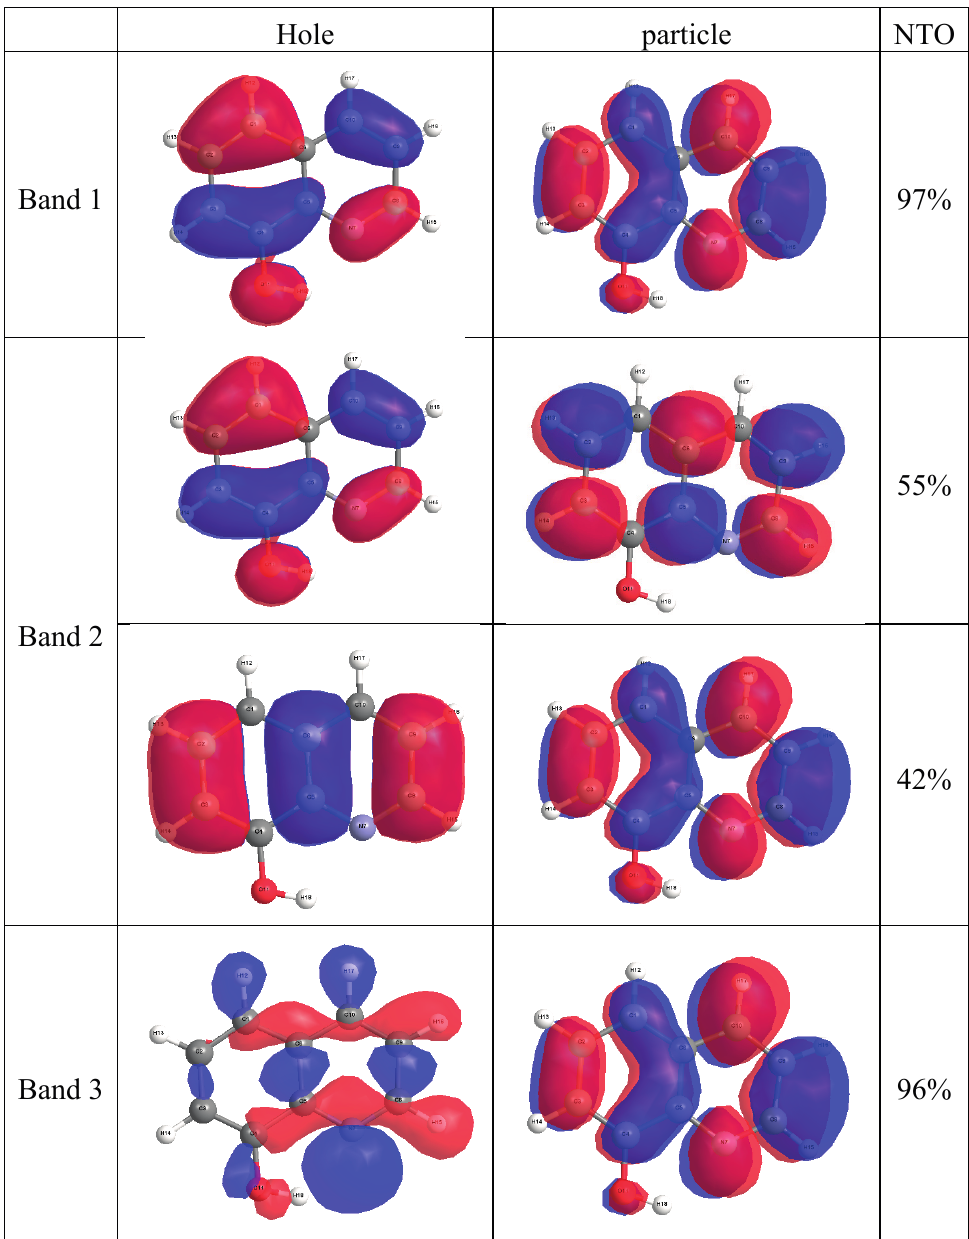
4. Natural Transition Orbital (NTO) for 8-HQ compound at CAM-B3LYP/6-311++G** level of